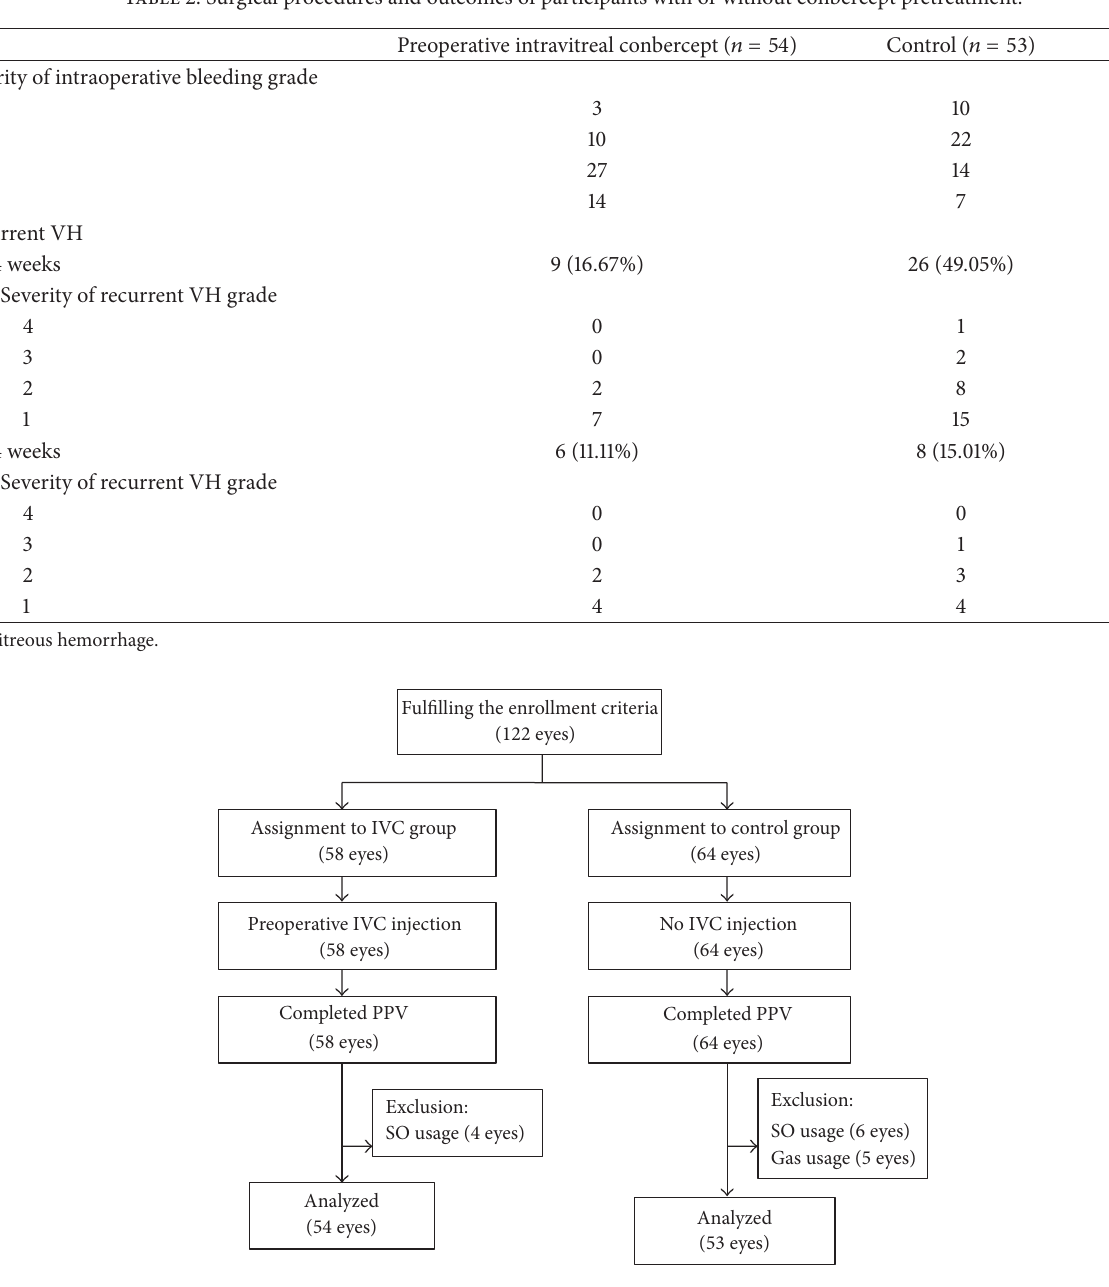
Figure 1: Chart showing participants flow. IVC: intravitreal conbercept; PPV: pars plana vitrectomy; SO: silicone